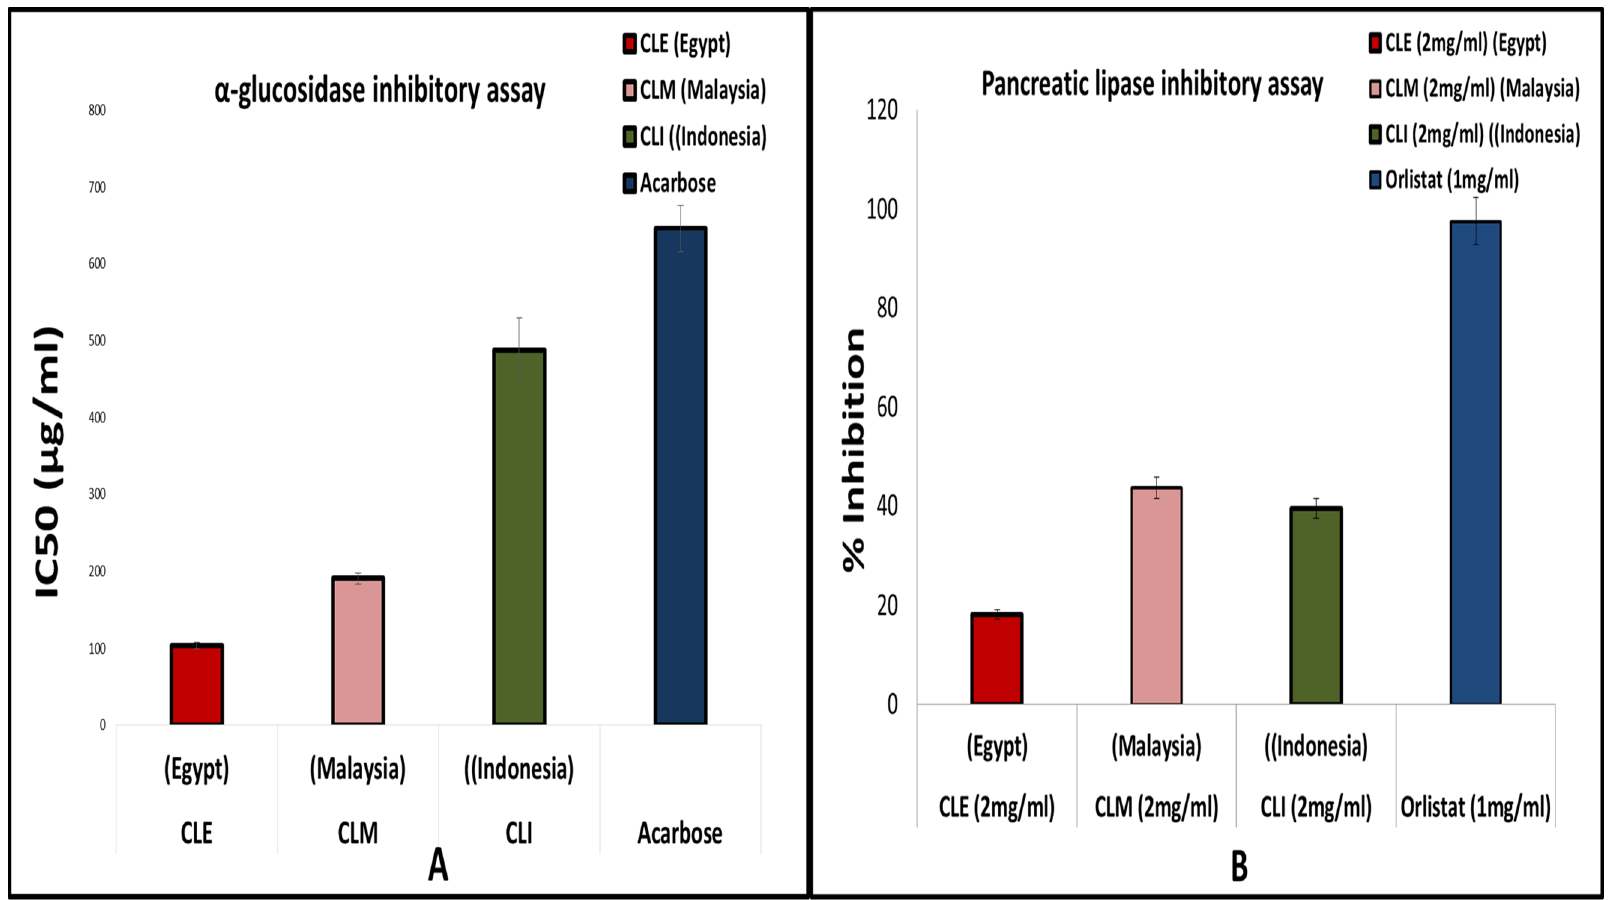
Figure 7. α-Glucosidase and pancreatic lipase inhibitory assays of ripe fruit extracts grown in Egypt (CLE), Malaysia (CLM), and Indonesia (CLI). ( A ) α-Glucosidase inhibitory assay, IC 50 in (μg/mL) of fruit samples versus acarbose as positive drug control. ( B ) Pancreatic lipase inhibitory assay of fruit samples tested at 2 mg/mL compared to orlistat (at 1 mg/mL) ( n = 3).